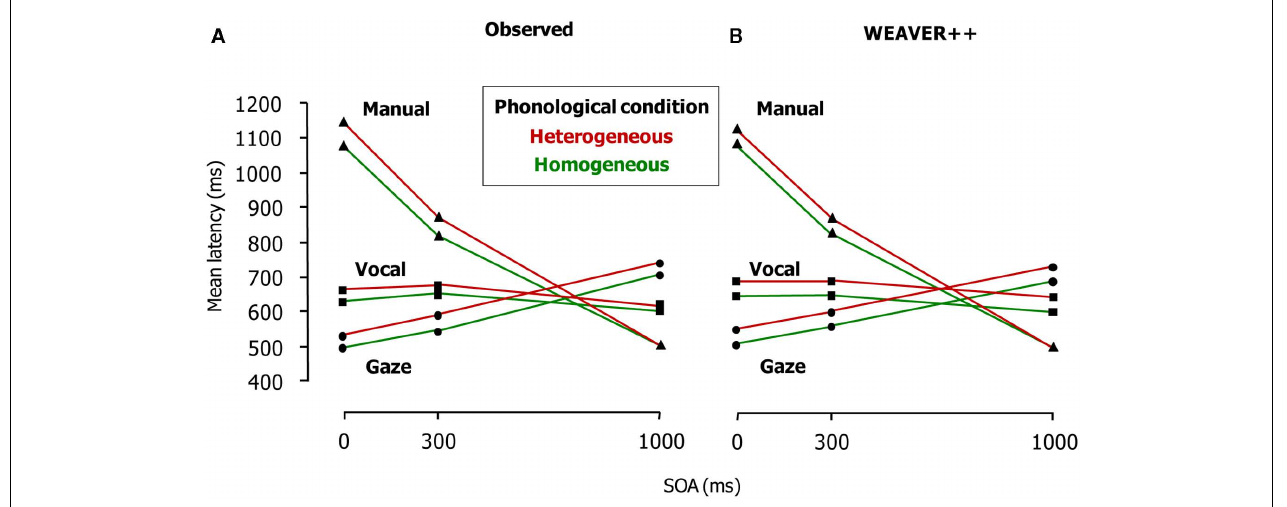
FIGURE 3 | Latencies of vocal responding (Task 1), gaze shifting, and manual responding (Task 2) in the dual-task study of Roelofs (2008a; Experiment 1). (A) Shows the real latency data of the eye tracking experiment and (B) shows the results of the computer simulations. SOA = stimulus onset asynchrony.